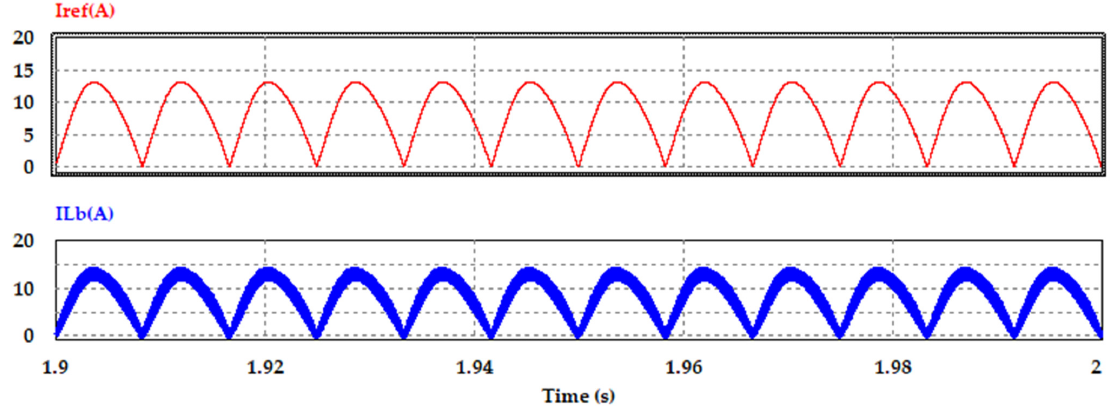
Figure 15. Voltages, currents, and input power factor for the interleaved CCM PFC at full load condition.